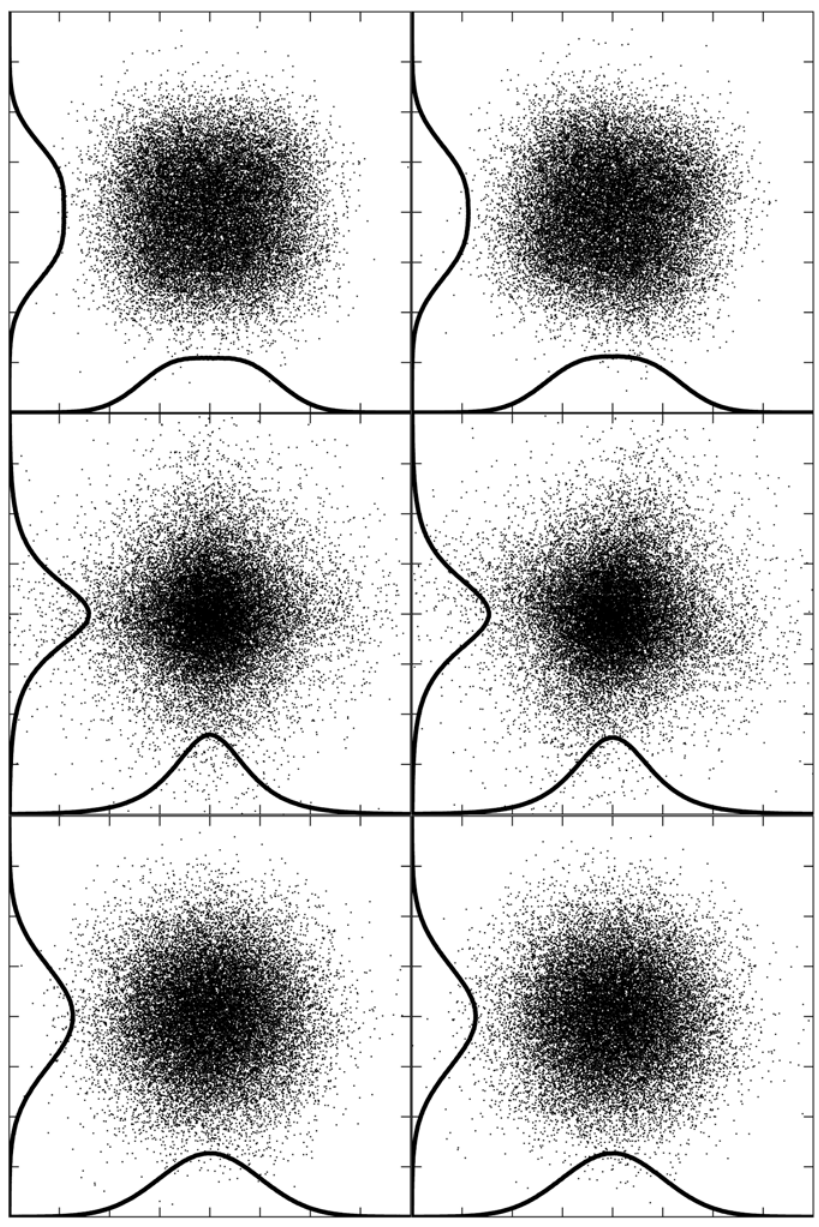
Fig 1. Mixtures of non-Gaussian and of Gaussian sources. Points with x- and y- coordinates drawn from two unmixed source distributions are plotted in the left panel. At the top, both sources were randomly drawn from a sub-Gaussian distribution; in the middle, both from a super-Gaussian distribution; and at the bottom, both from a Gaussian distribution. Corresponding images on the right show the distributions after the sources on the left were remixed with an orthonormal matrix representing a thirty degree rotation. For the non- Gaussian sources, the lack of statistical independence resulting from the rotation can be identified visually even without seeing the unrotated images as a result of the higher order distributional statistics. Statistical independence in the unmixed images is evident from the fact that the two-dimension distribution can be predicted as the product of the illustrated marginal distributions along each individual axis. When both sources are Gaussian, the two-dimensional distribution can be predicted from the marginal distributions of any arbitrary orthogonal pair of coordinate axes, so statistical independence cannot be used as a criterion for identifying the original Gaussian sources.